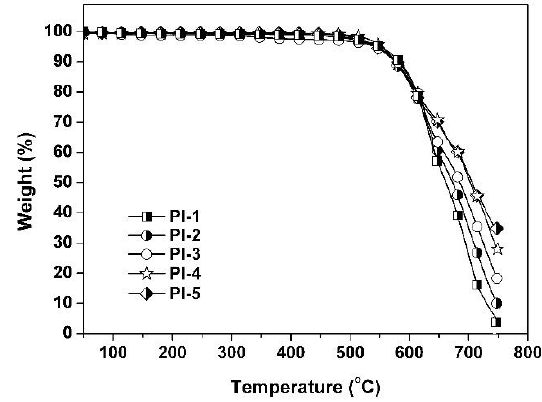
Figure 6. Thermogravimetric analysis (TGA) plots of PI coatings in air. Table 2. Thermal properties of PI coatings.